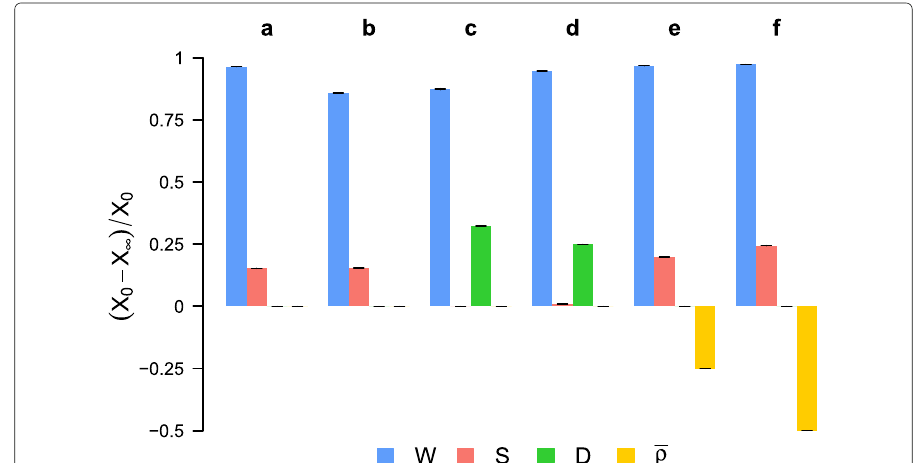
Fig. 4 Multi-criteria improvement of shopping mobility. Each group of bars gives the relative gains or losses for the four indicators W , S , D and ¯ ρ . Experiments are described in Table 1. See Additional file 1: Figure S13